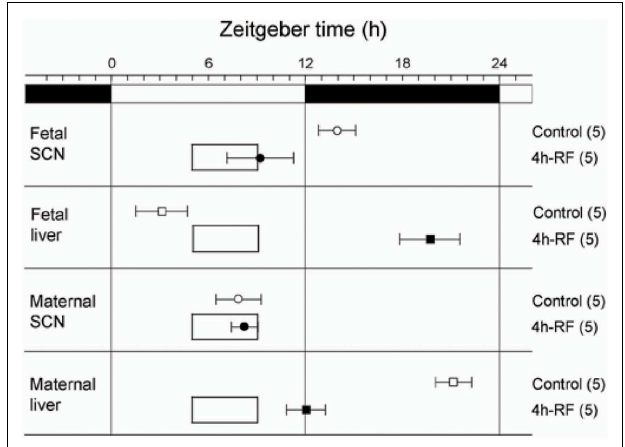
FIGURE 3 | Effects of 4h restricted-feeding on tissue luciferase rhythmicity .The average times ( ± SD, shown by error bars) of peaks from the different tissues are plotted against the LD cycle shown at the top of each panel.The timing and duration of food availability at ZT5-9 is indicated by open boxes in each section.The sample size is shown in parentheses. The phases of Per1::Luc fetal SCN, fetal liver, and maternal liver rhythmicity were significantly different from control values in all groups of RF rats (one-way ANOVA, p < 0.01); the phase of maternal SCN rhythmicity was not significantly different between control and 4h-RF